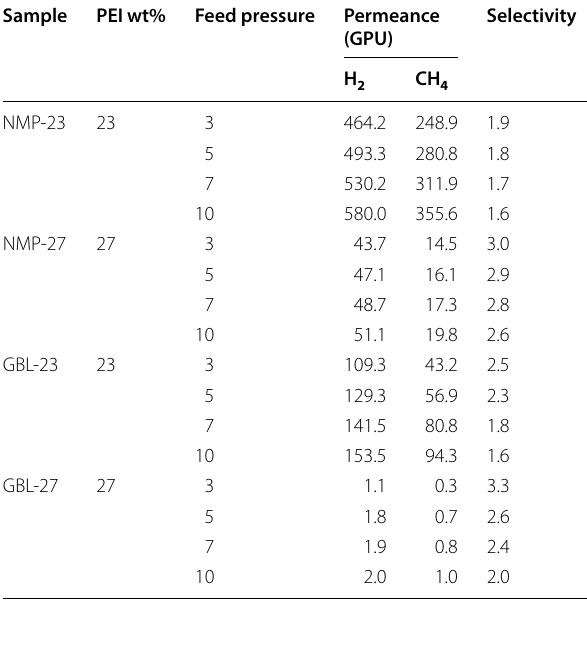
Table 4 Hydrogen and methane data